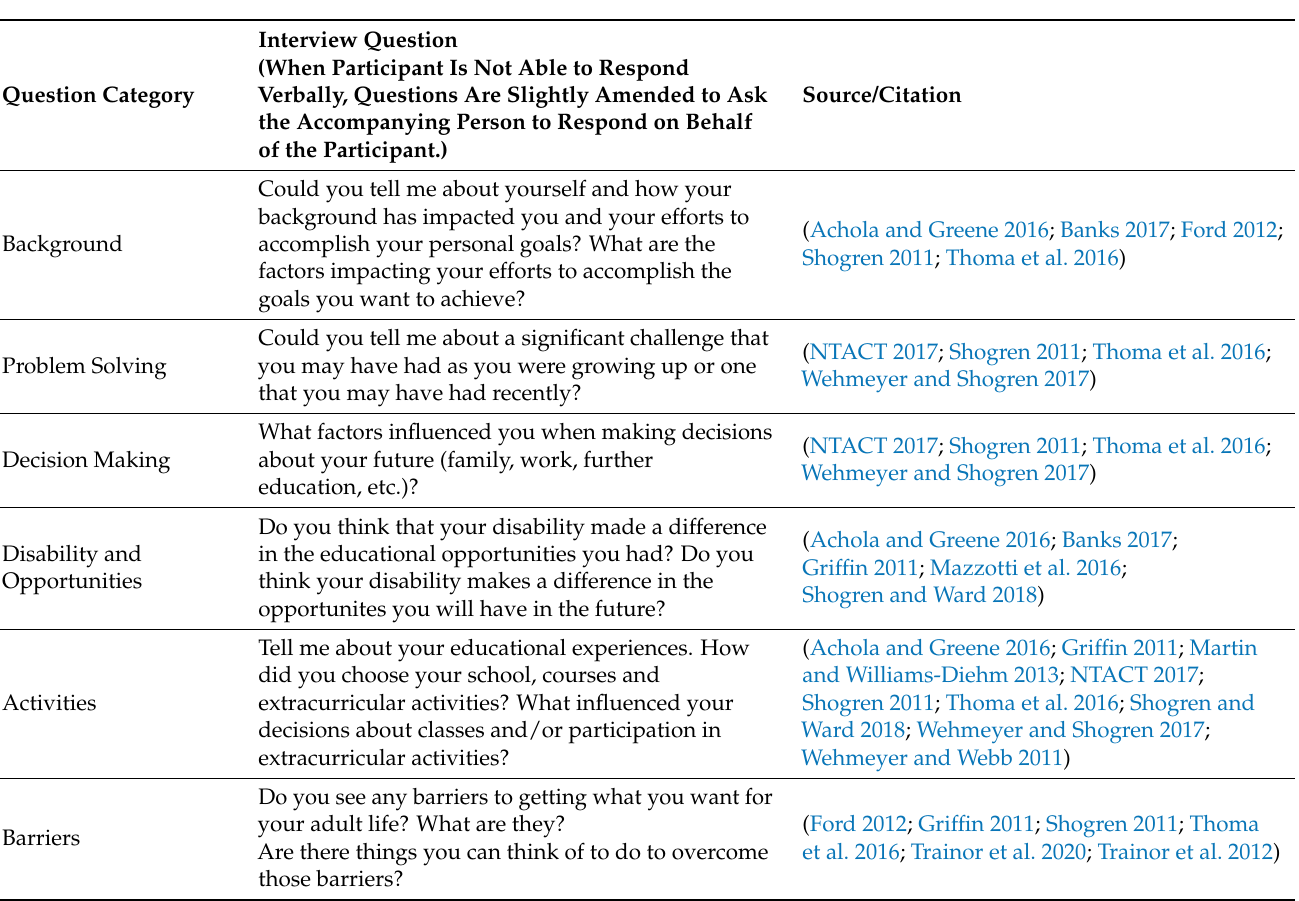
Table 1. Sample interview questions adapted from the respective